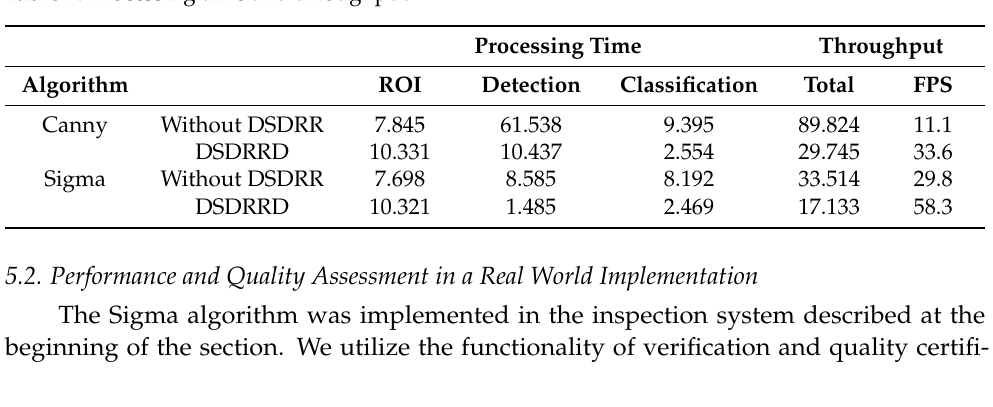
Table 7. Processing time and